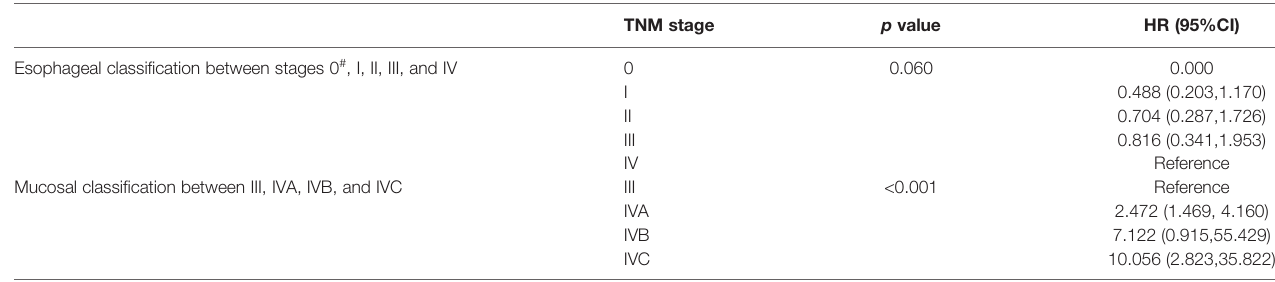
TABLE 3 | Univariate Prognostic Factor Analysis for overall survival by Cox Proportional-hazards